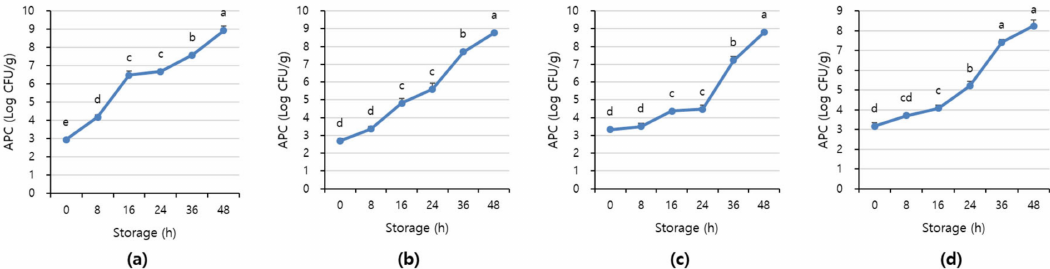
Figure 7. The APC level of ( a ) beef loin (quality grade 1+), ( b ) beef loin (quality grade 1), ( c ) beef round (quality grade 1+), and ( d ) beef round (quality grade 1) over the storage periods at room temperature (23 ◦ C). a–e Different superscript letters above bars indicate a significant difference at p < 0.05.